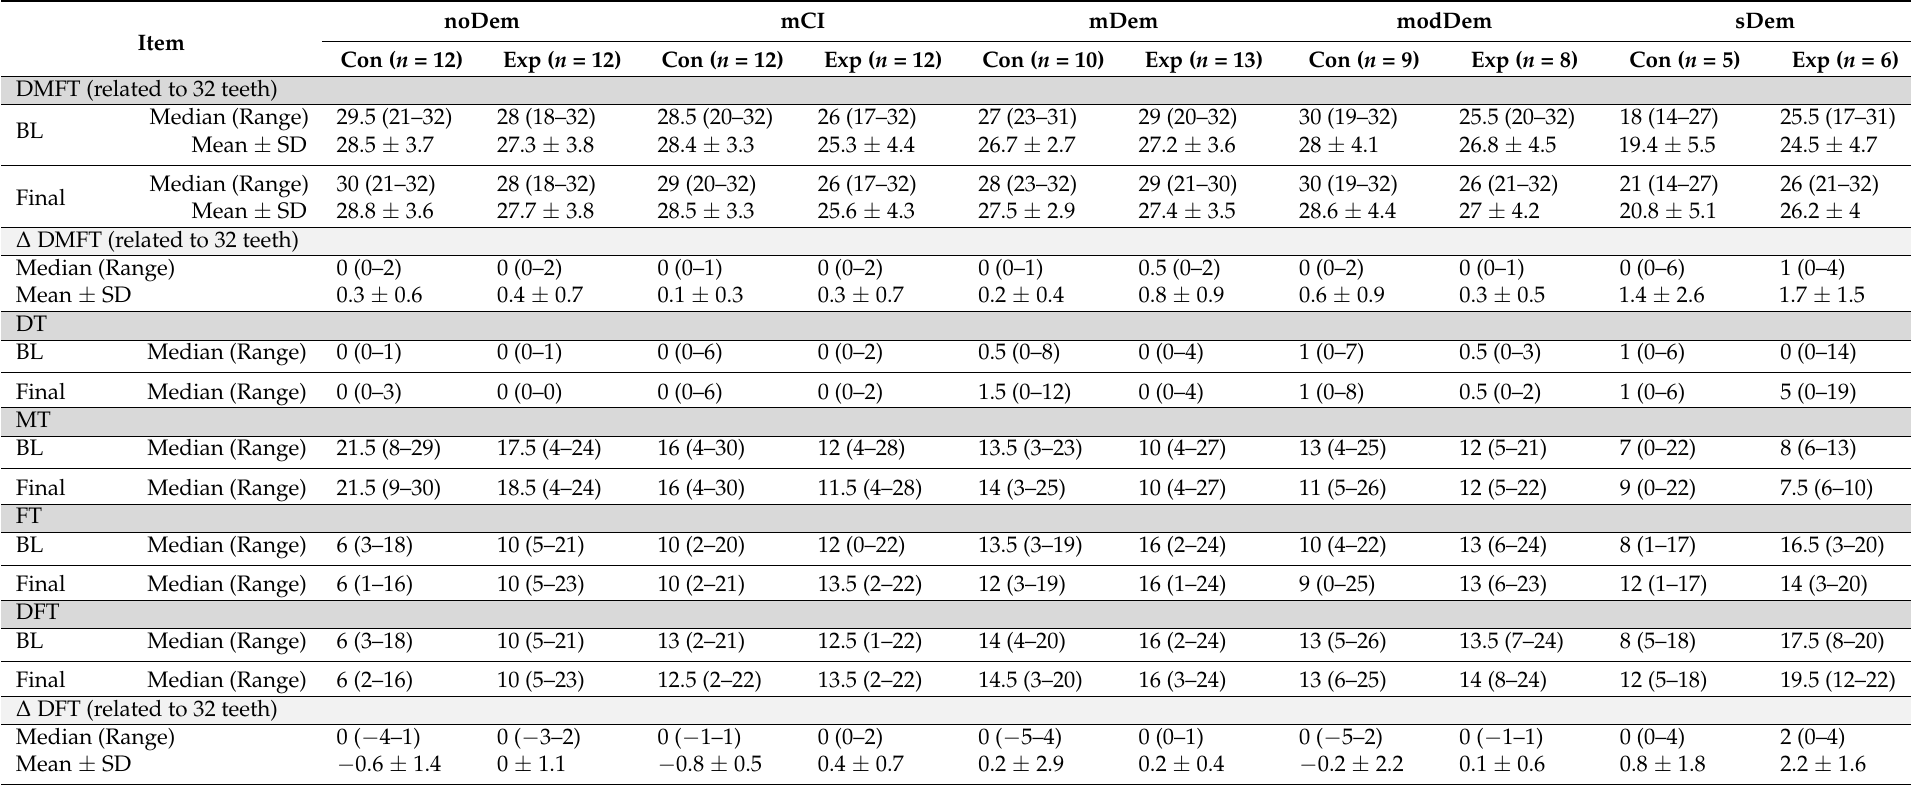
Table 2. DMFT-Index (related to 32 teeth) and its components and ∆ DMFT and ∆ DFT, separated by mini mental state examination (MMSE) group and